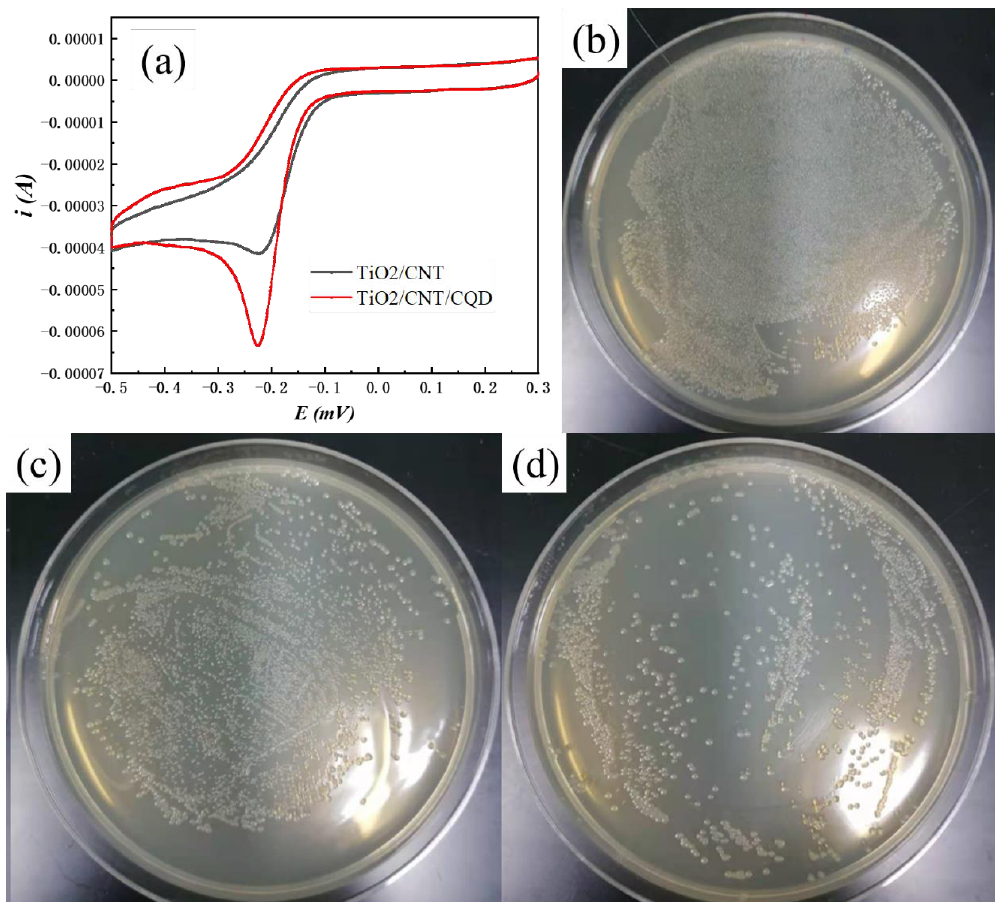
Figure 5. ( a ) CV curves and anti-bacterial properties of ( b ) control, ( c ) TiO 2 /CNT, and ( d ) TiO 2 /CNT/CQD using Escherichia coli.